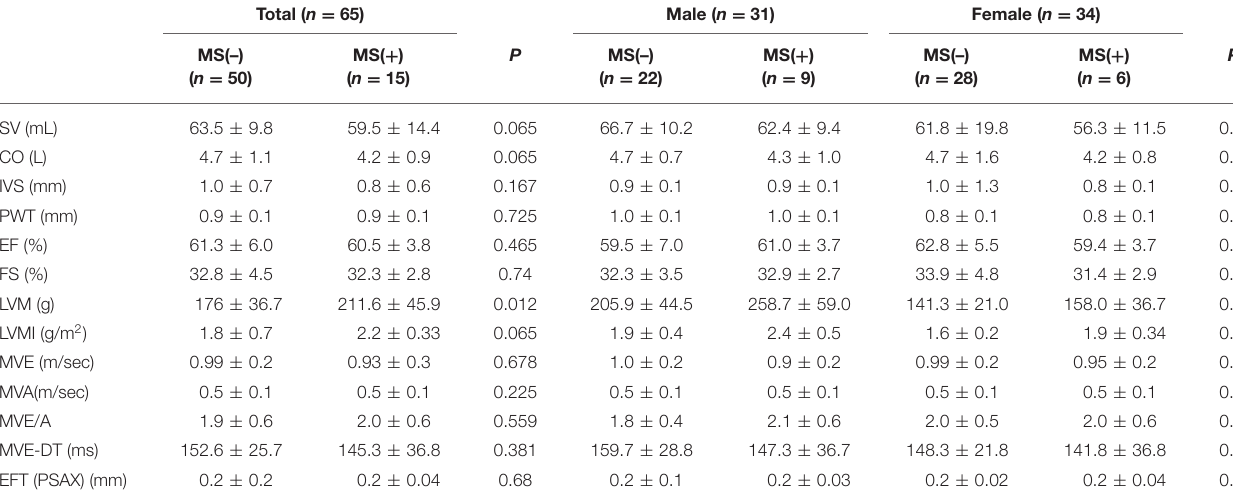
TABLE 6 | Comparison of echocardiographic data in the obese